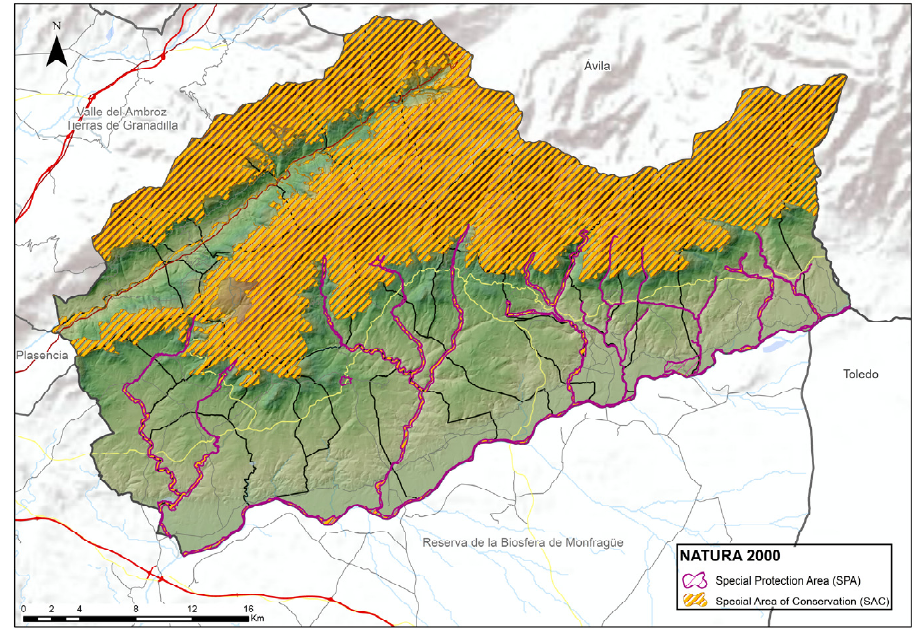
Figure 8. Map of the European Ecological Network Natura 2000.